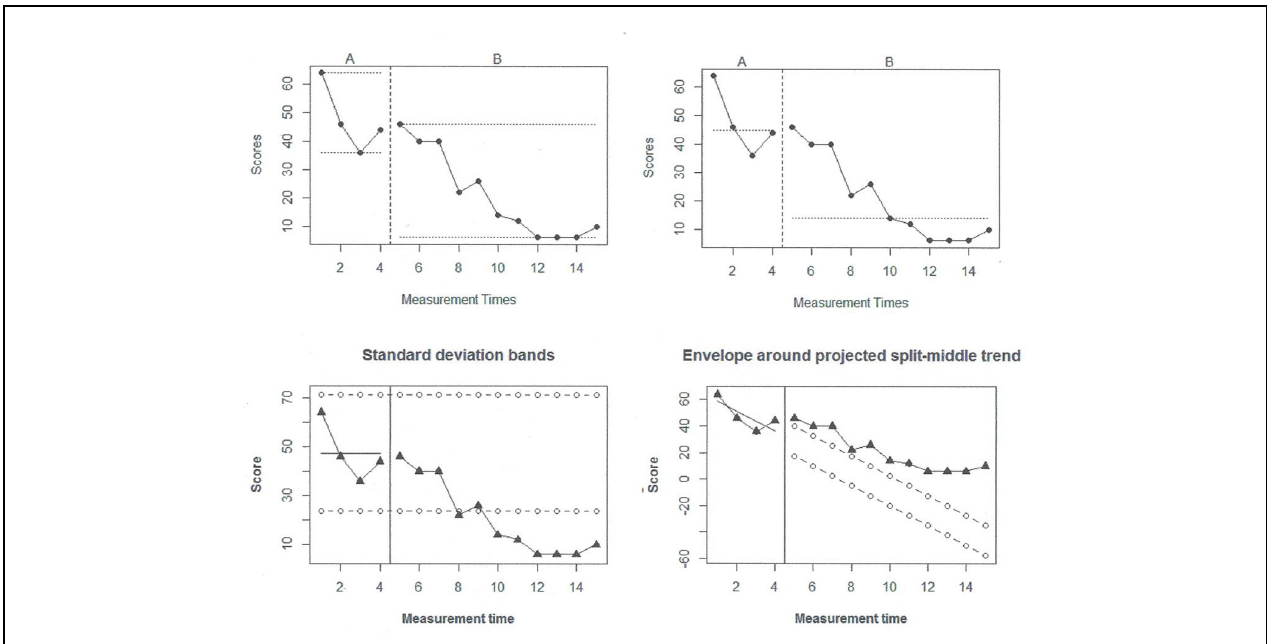
FIGURE 2 | An illustration of visual sides using Taylor and Weems (2011) data on a participant called Elizabeth. Upper left panel − range bars. Upper right panel − medians. Lower left panel − 2-standard deviation bands. Lower right panel − stability envelope around split middle